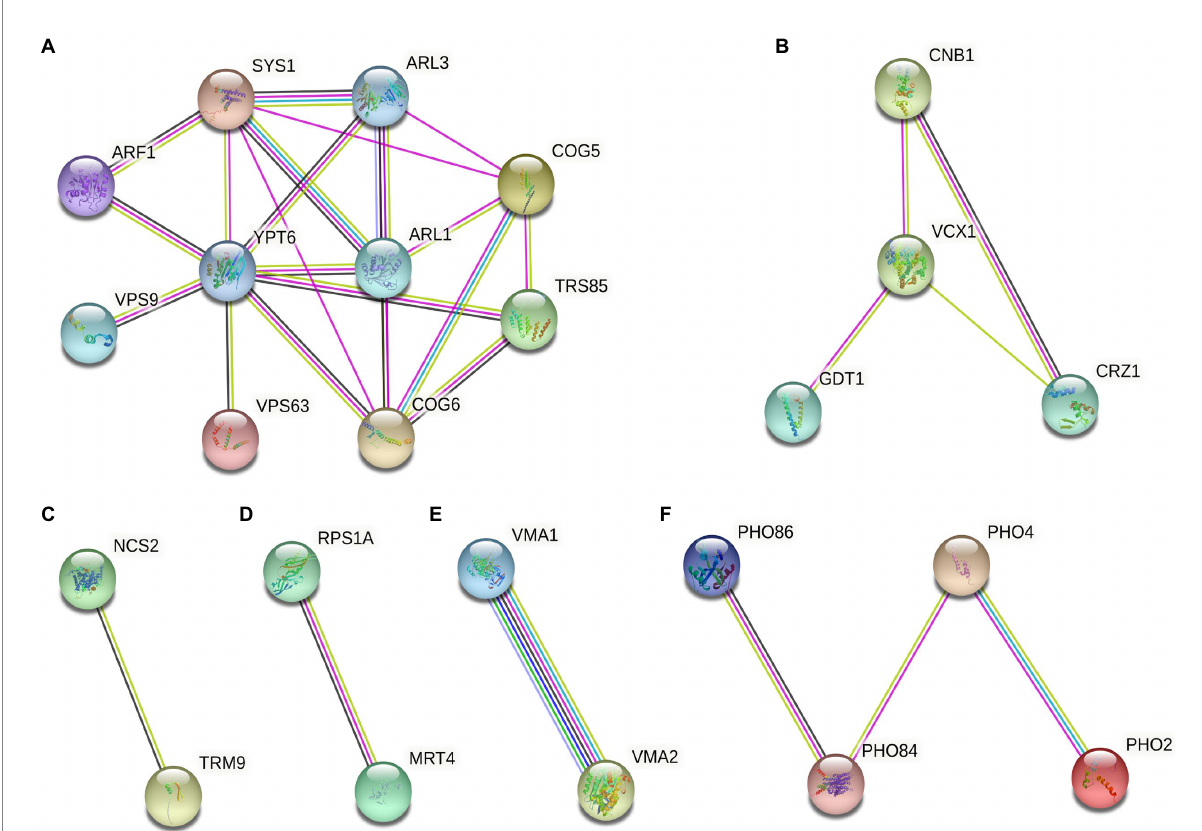
FIGURE 5 Gd toxicity modulating networks identified with proteins whose absence renders cells sensitive to Gd. (A) Gd sensitive genes ( ARF1 , ARL1 , ARL3 , SYS1 , COG5 , COG6 , YPT6 , VPS9 , SSO2 , MRL1 , AKL1 , and TRS85 ) were associated with the intracellular vesicle transport; (B) Gd sensitive genes ( CNB1, MCK1, VCX1, and CRZ1 ) were involved in calcium signaling pathway; (C) Gd sensitive genes NCS2 and TRM9 were associated with the modification of tRNA wobble position; (D) Gd sensitive genes PRS1A and MRT4 participated in protein synthesis; (E) Gd sensitive genes VMA1 and VMA2 were the subunit A and Subunit B of V1 peripheral membrane domain of V-ATPase; (F) Gd sensitive genes ( PHO84 , PHO86 , PHO2 , and PHO4 ) participated in phosphorus metabolism. The proteins corresponding to Gd sensitive gene deletion strains were mapped onto the interactome, and then filtered to identify the connected groups of proteins (https://cn.string-db.org/). The minimum required interaction score was set at high confidence 0.7. The straight lines indicate the protein–protein